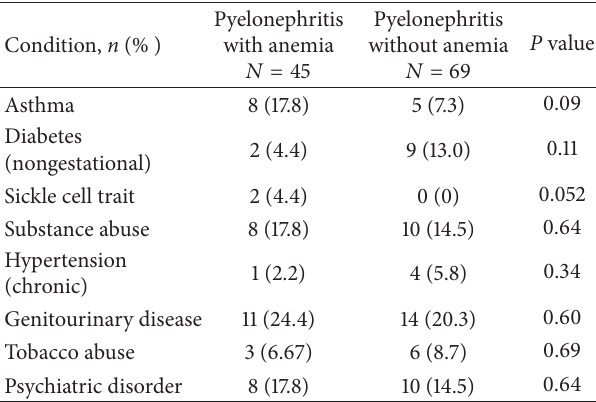
Table 2: Preexisting medical conditions. Table 3: Pyelonephritis admission data.